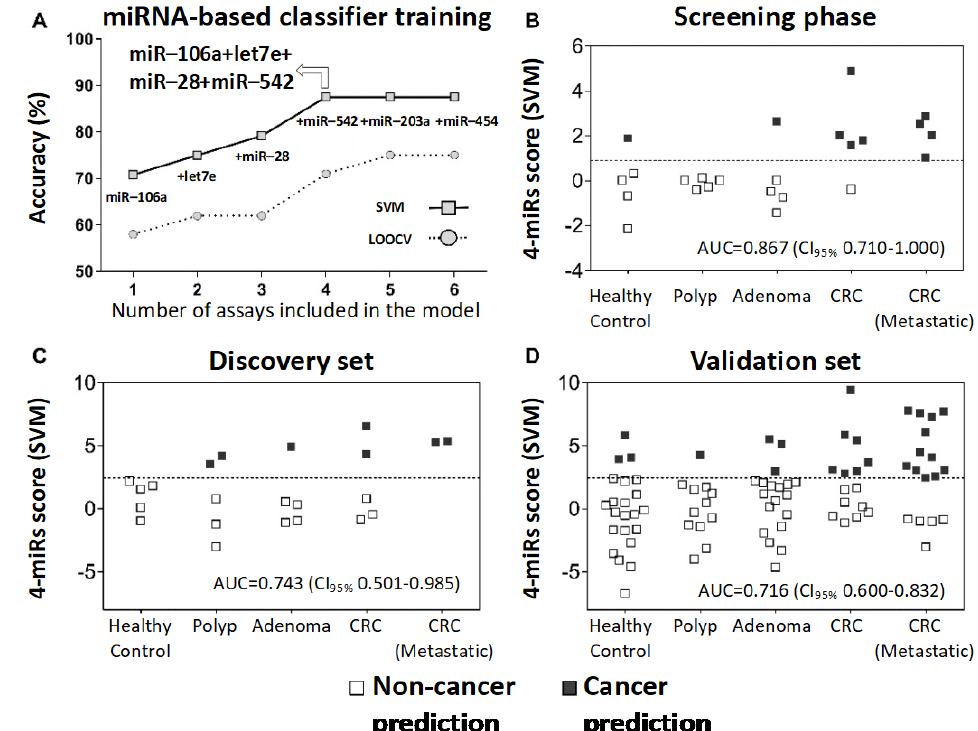
Figure 3. Training and validation of the circulating miRNA-based diagnostic classifier. ( A ) Cancer prediction models including one to six miRNAs (selected by the recursive elimination method) previously detected at higher levels in the blood samples of CRC patients. Representative graphs of overall yield accuracy and LOOCV estimative. ( B ) Application of the four-miR-based classifier (miR-106a + let-7e + miR-28 + miR-542) in the screening phase (evaluated by the TLDA assay). ( C ) The four-miR-based classifier applied to a subset of cases of the discovery set (screening phase) using individual RT-qPCR assays. ( D ) Application of the four-miR-based classifier to a group of samples independent of the screening phase (validation set) using individual RT-qPCR assays. The dotted line indicates the threshold above which a malignant status would be predicted. SVM: support vector machine; LOOCV: leave-one-out cross-validation; AUC: area under the ROC curve; CI 95% : 95% confidence interval.